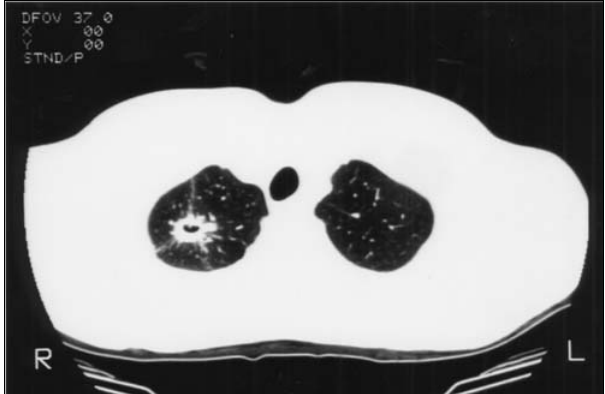
Figure 1) A Computerized Tomography (CT) scan of the thorax con- firmed a 2 cm cavitary right upper lobe lesion with thick walls and fibrotic strands extending from the wall measuring 3 to 4 mm